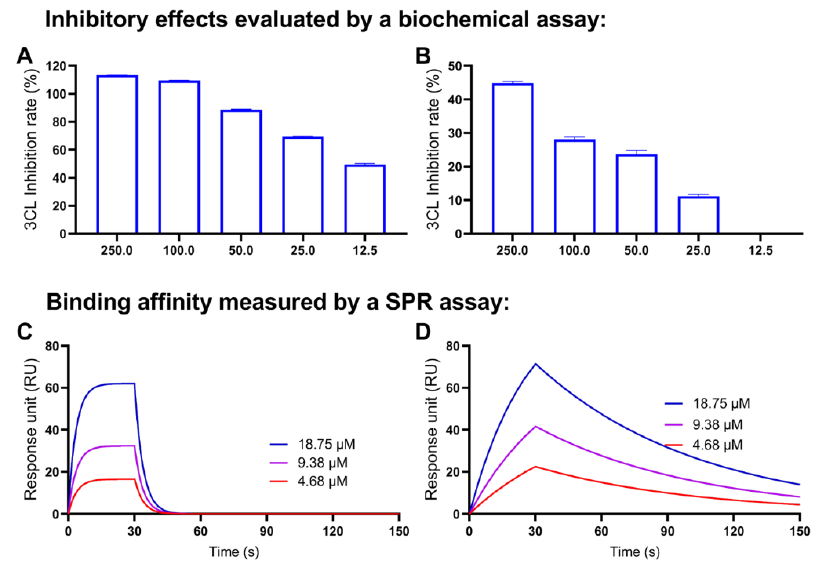
Figure 7. Concentration-dependent inhibitory effects of the CBG-type cannabinoids on the M pro activity (evaluated by a biochemical enzyme inhibition assay) and their binding capacity to the M pro protein (measured by the SPR assay). The IC 50 values of CBGA ( A ) and CBG ( B ) were calculated by data from a biochemical assay with the GraphPad Prism8. The binding affinities between CBDA or CBD and the M pro protein were determined by the SPR assay with a representative SPR sensorgram of the binding between CBGA ( C ) or CBG ( D ) and the M pro protein.